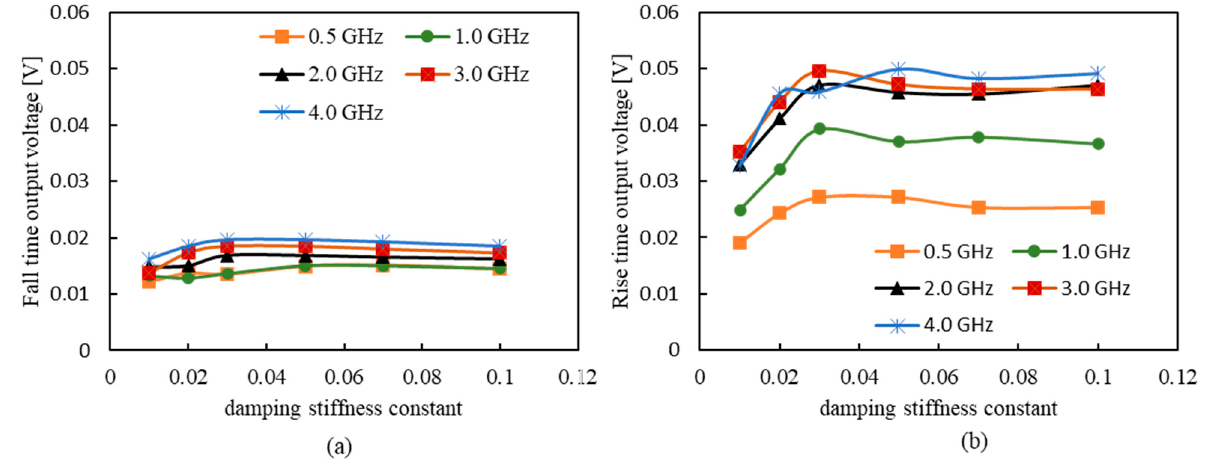
Figure 7. Damping constant dependence of output voltage: ( a ) rise-time output voltage; ( b ) fall-time output voltage.